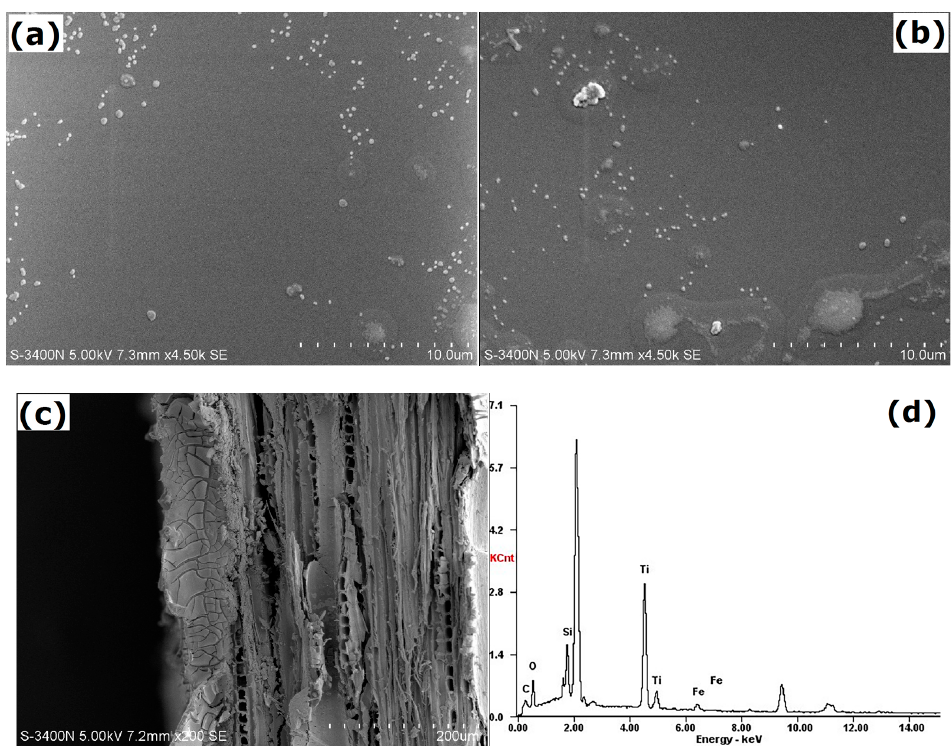
Figure 2. SEM images of ( a ) STCF, ( b ) STCF doped with Fe 3+ , ( c ) the joint surface of wood and composite film, and ( d ) the corresponding EDAX spectrum of STCF-1.